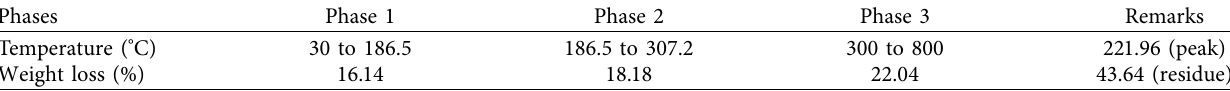
Table 3: Different stages of the TGA for Ceramium rubrum .